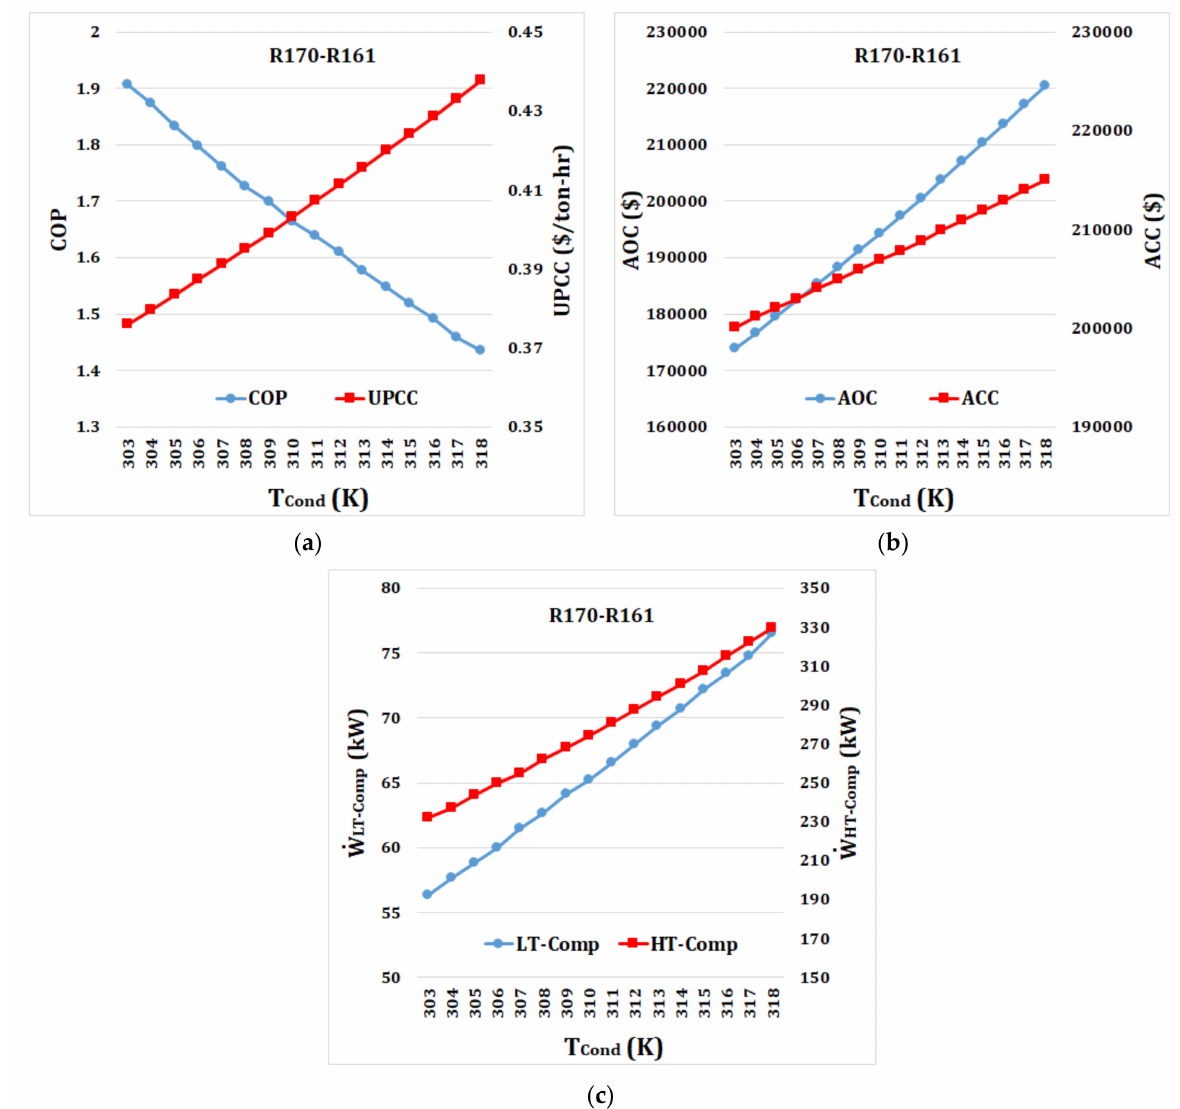
. . W LT − Comp and W HT − Comp of the optimized